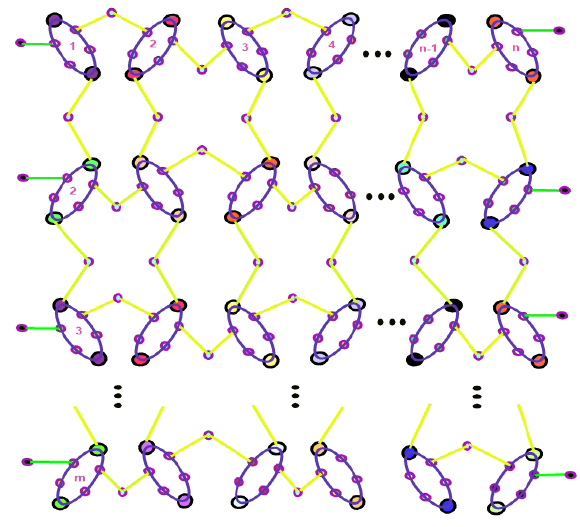
Figure 3: Hydrogen depleted molecular graph of Bakelite network